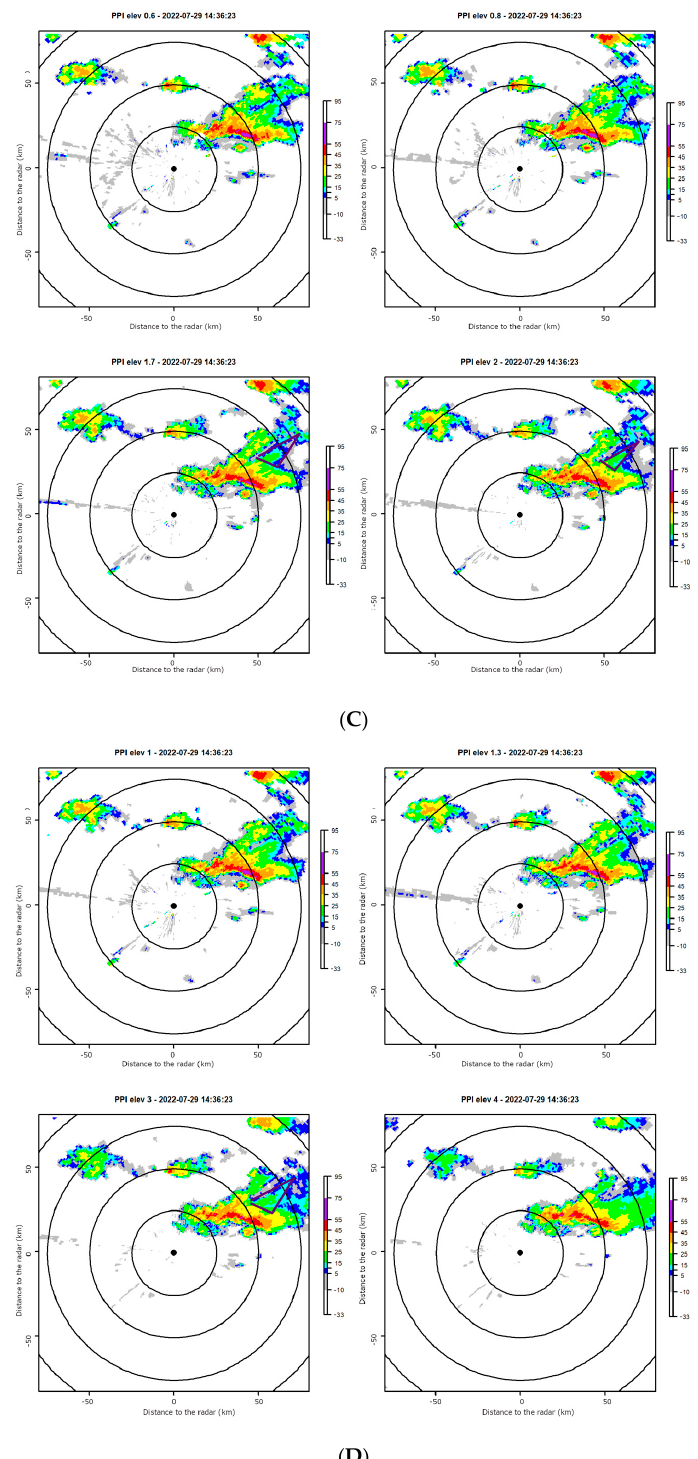
Figure 6. ( A ) Elevations of the PPI fields (0.6, 0.8, 1.7, and 2 ◦ ) of the same case as Figure 4 (PDA radar, 29 May 2022). ( B ) As in Figure 6A for the 1, 1.3, 3, and 4 ◦ PPI elevations (PDA radar, 29 May 2022). ( C ) As in Figure 6A, but for the CDV radar (29 July 2022). The TBSS signature is marked with a purple triangle (in 1.7 and 2 ◦ PPI elevations). ( D ) As in Figure 6B, but for the CDV radar (29 July 2022). The TBSS signature is marked with a purple triangle (in 3 ◦ PPI